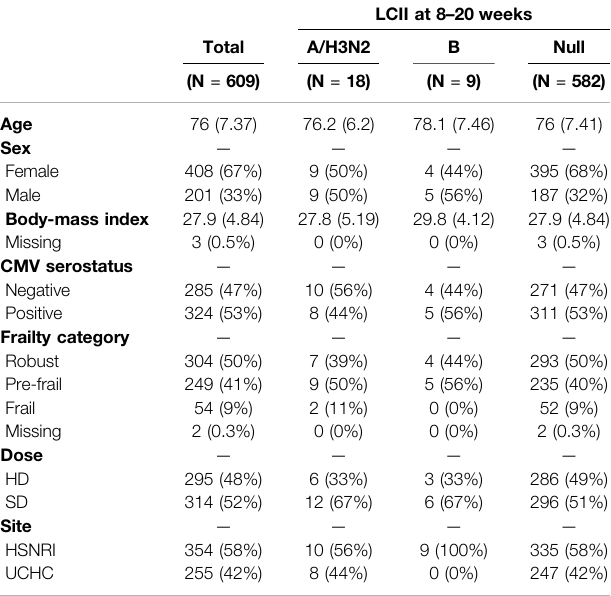
Table S2 ) and similar results were observed for B/Lee- ( Figure 2B , right panel; Supplemental Table S2 ). Following natural infection,